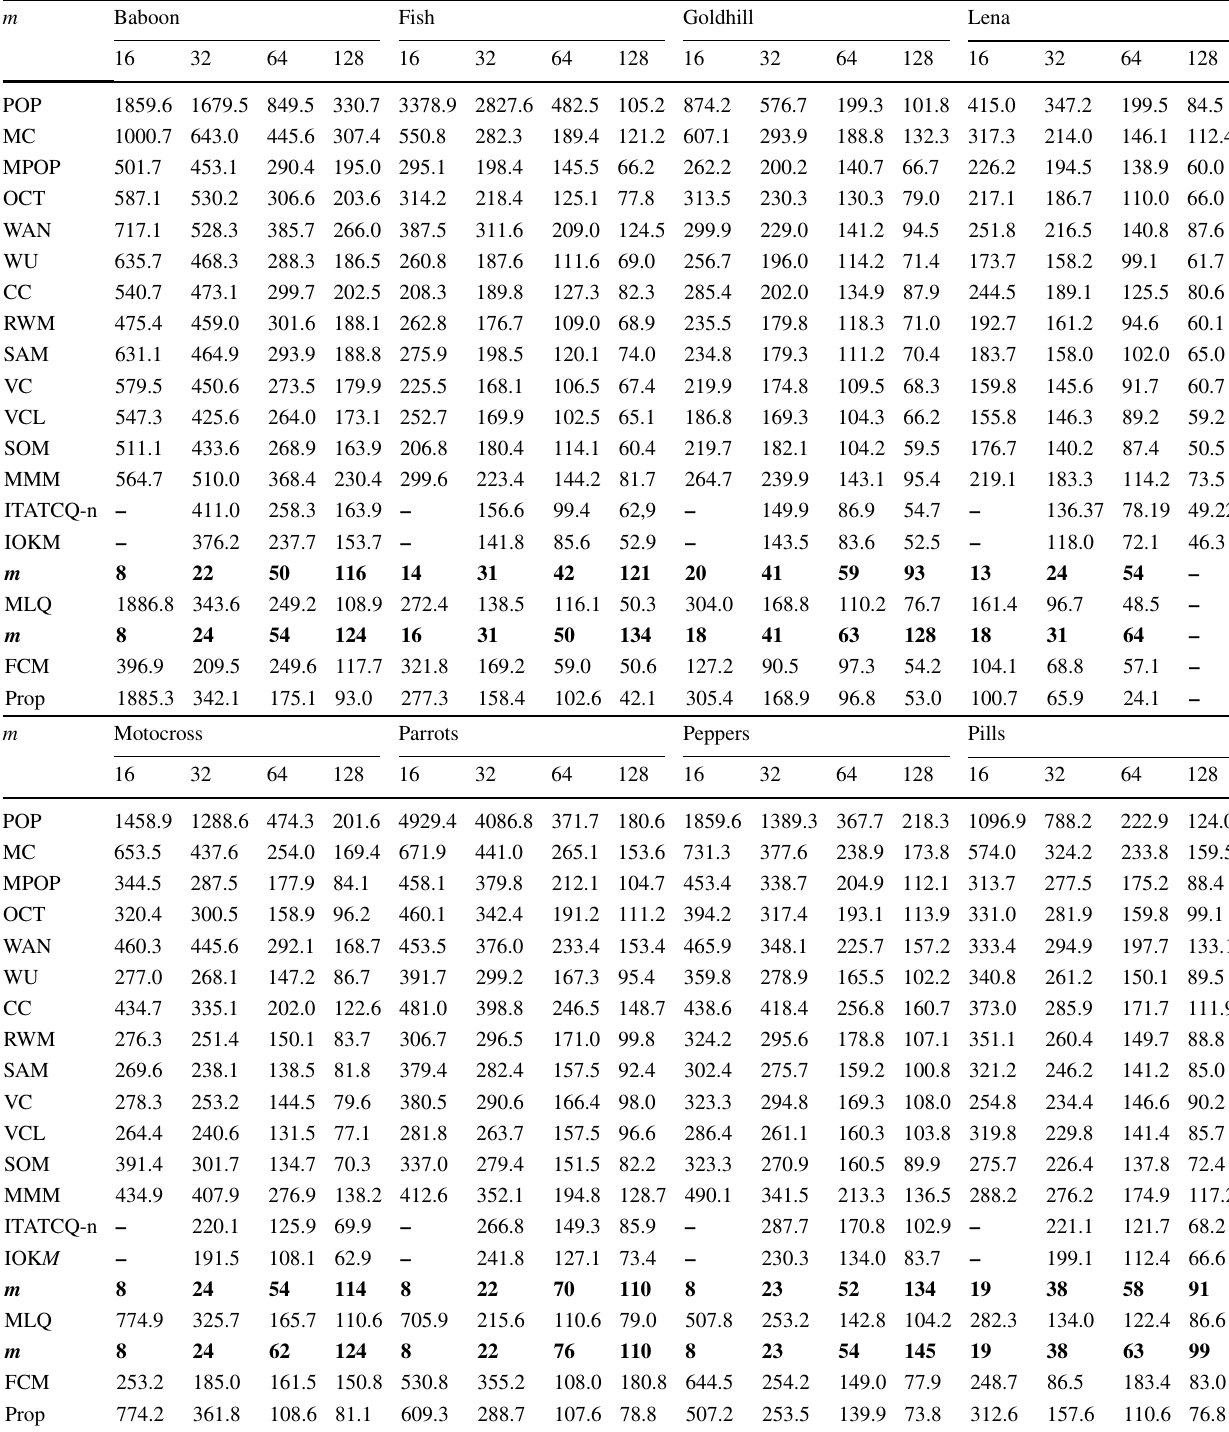
Table 7 MSE results of quantization